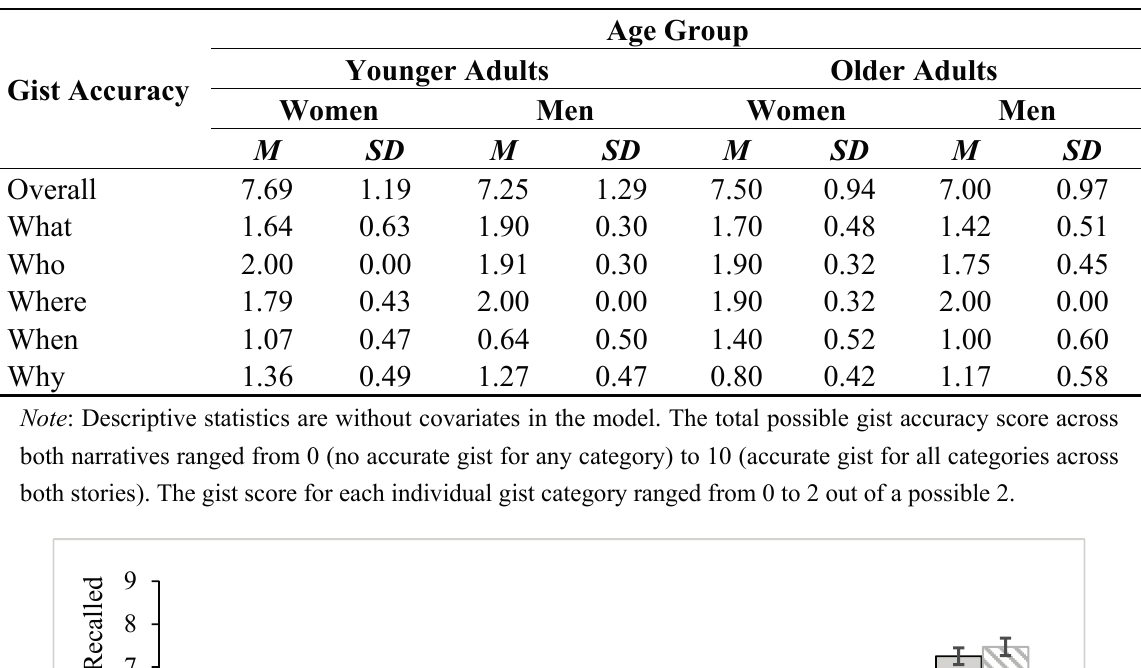
Table 3. Overall and category accuracy of gist recall by age and gender.